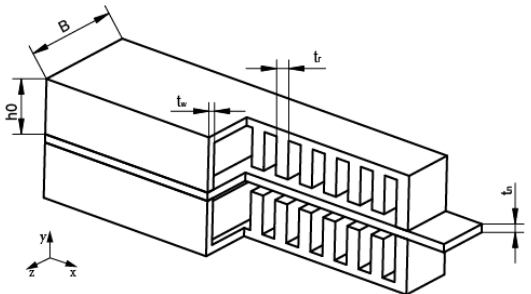
Figure 1. The dimensions of the bi-directionally pneumatic